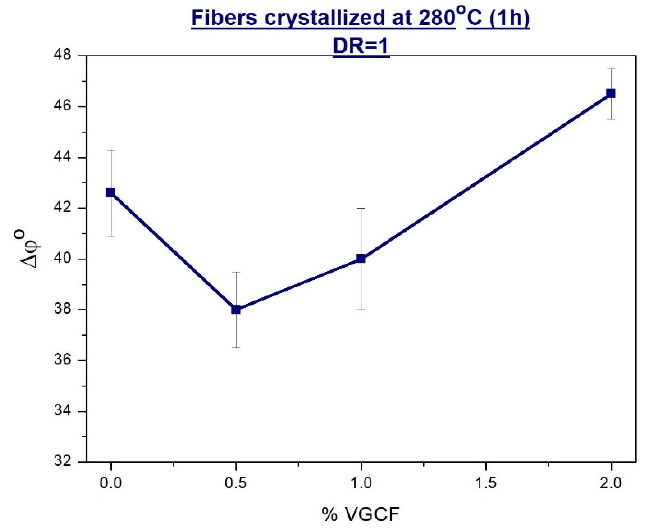
Figure 6. Dependences of the misorientation angle (along the fiber axis) of the crystallites on the content of the nanoparticles in the unoriented (DR = 1) composite fibers based on R-BAPB.